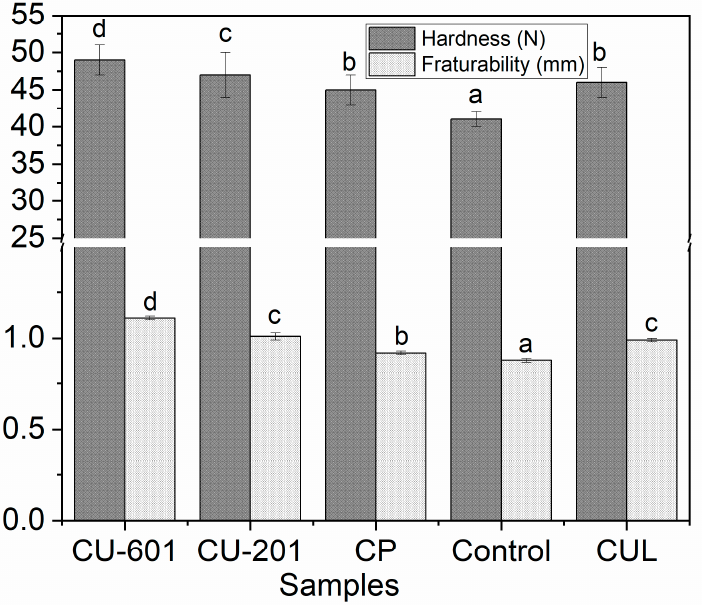
Figure 3. Textural analysis of cookies prepared with pectin with different molecular structure and molecular weight. CUL, CP, CU-601 and CU-201 indicate the names of pectin which were added in cookies. Reported graphs are the mean of triplicates for each treatment. Small letters over error bars represent the significant difference between treatments at a level of p < 0.05 using one-way ANOVA and Duncan multiple range test.